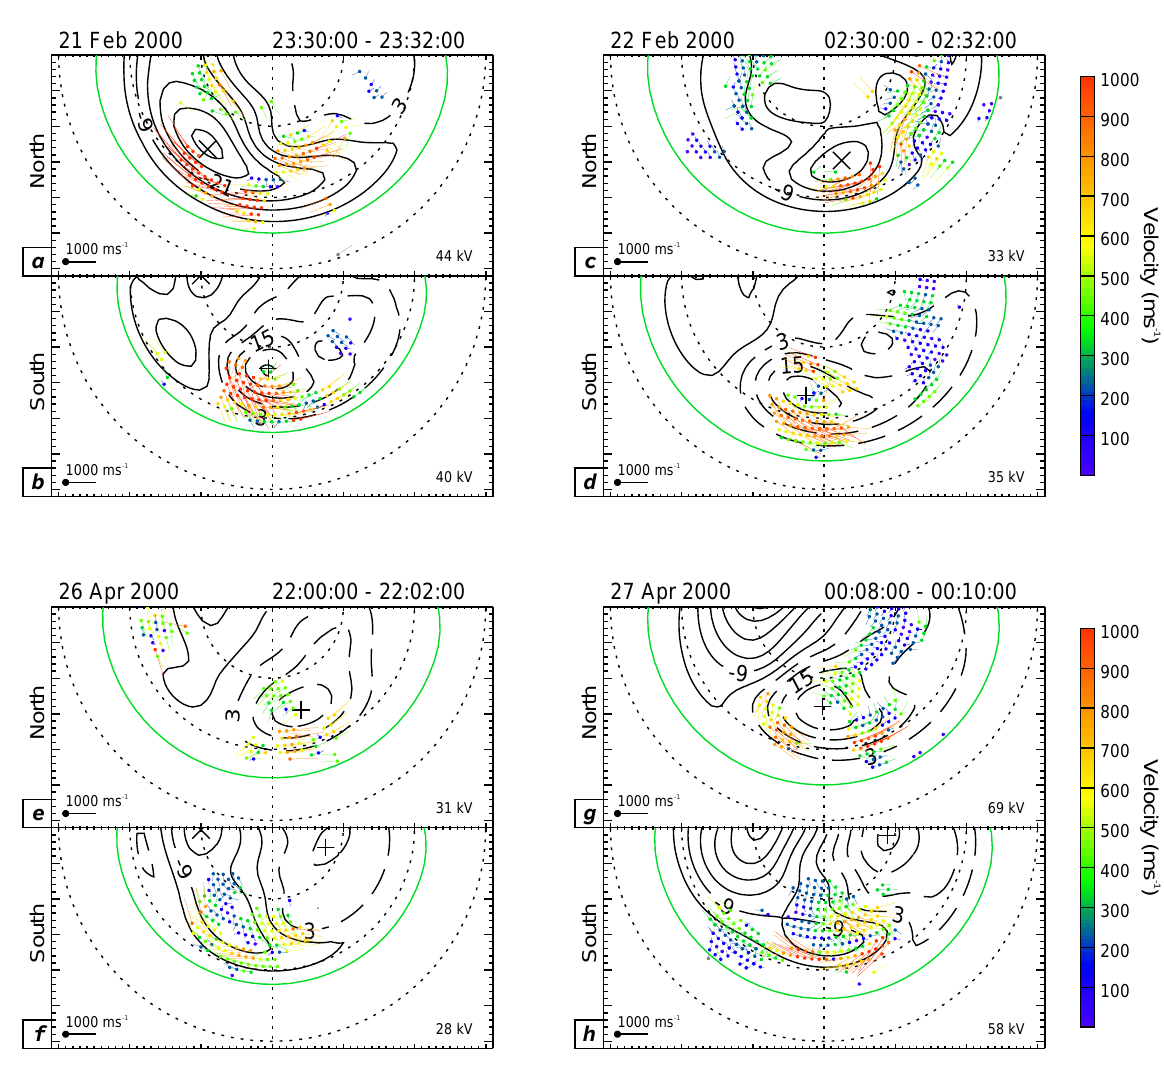
Fig. 2. Streamlines and vectors of the nightside ionospheric flows derived from SuperDARN velocity measurements. These data are shown on geomagnetic latitude-MLT grids, with midnight at the bottom and dusk to the left. Each map-pair corresponds to the vertical lines in Fig. 1, the times of which are indicated in the top right-hand corner of each pair. The transpolar voltage is indicated in the bottom right-hand corner of each map and the colour bars indicate the magnitude of the flow